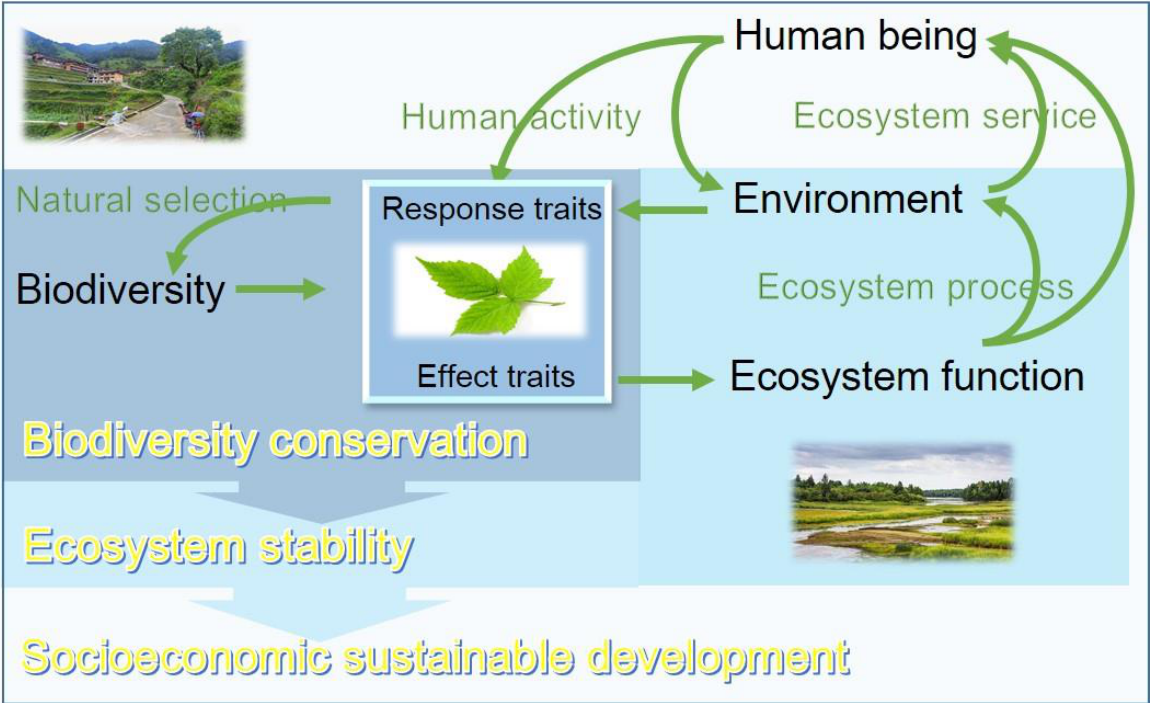
Figure 5. Response-effect trait framework.